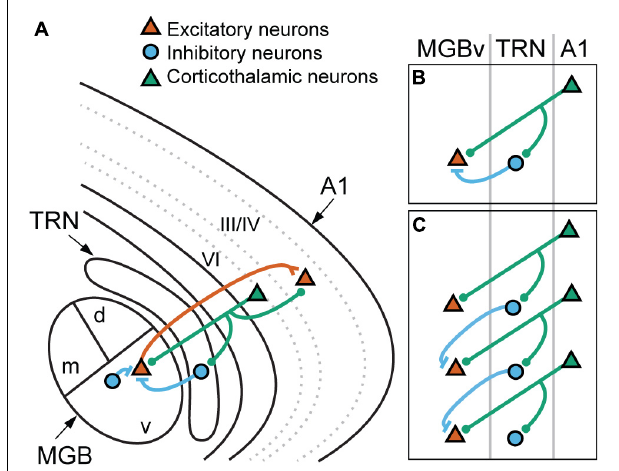
FIGURE 2 | Corticothalamic connections to the lemniscal thalamus mediated via the thalamic reticular nucleus. (A) Schematic illustration of thalamocortical and corticothalamic connections. Thalamocortical neurons (red) in the ventral division of medial geniculate body (MGBv) project mainly to the neurons in layer III/IV of the primary auditory cortex (A1). The collaterals innervate to the thalamic reticular nucleus (TRN) but are not depicted in the diagram for simplicity. Corticothalamic neurons (green) in layer VI project back to the MGBv with the collaterals to the TRN and layer III/IV of A1. TRN and local GABAergic neurons provide inhibitory inputs (blue) to MGBv neurons. (B,C) Potential roles of the corticothalamic feedback. (B) Corticothalamic neurons modulate gain of MGBv neurons by regulating the balance of monosynaptic excitatory and disynaptic inhibitory inputs. (C) Corticothalamic neurons modulate tuning properties of MGBv neurons by lateral inhibition. The collaterals onto TRN spread along neighboring neurons with similar but not identical BFs, and the excitatory and inhibitory inputs to the MGBv neurons come from different corticothalamic cells. d, dorsal MGB; m, medial MGB; v, ventral